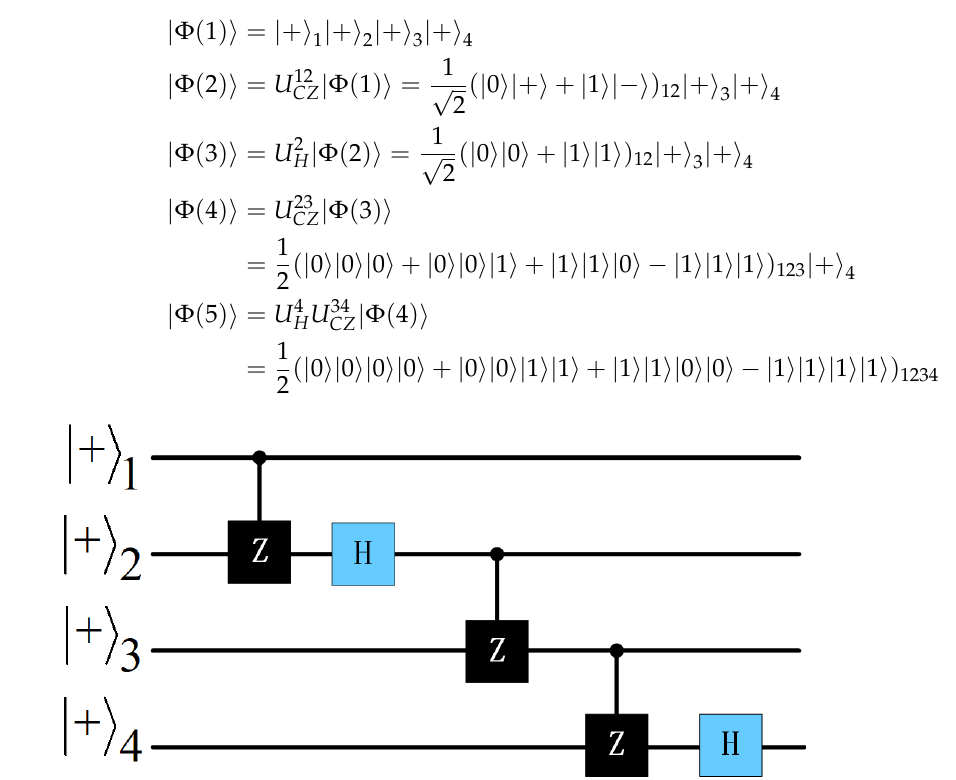
Figure 5. Process of generating 4-qubit cluster state using several quantum gates.